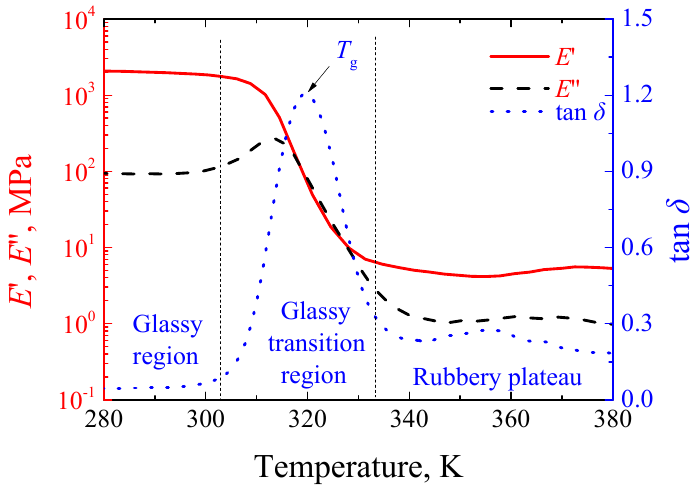
Figure 2. Dynamic mechanical analysis (DMA) curves of shape memory polyurethane (SMPU) ( E ’, E ’’ and tan δ denote the storage modulus, loss modulus and loss angle, respectively).